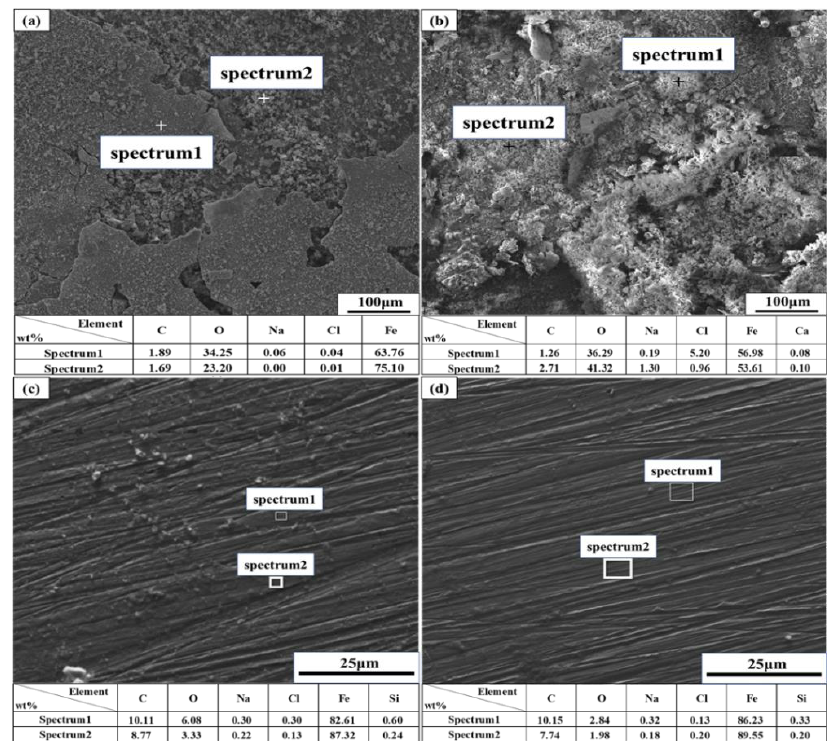
Figure 9. EDS analysis of iron after 4 weeks immersion in different simulated groundwaters. ( a ) SG solution. ( b ) SG + 20 mM CaCl 2 ; ( c ) SG + 20 mM Na 2 CO 3 ; ( d ) SG + 20 mM Na 2 SiO 3